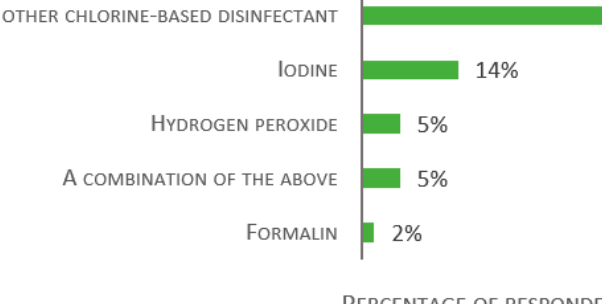
Figure 12. Responses to the multiple-choice question: “Which disinfectant do you use for egg surface sanitation?”, presented as percentage of respondents ( n = 111). Each respondent was allowed to select multiple answers.